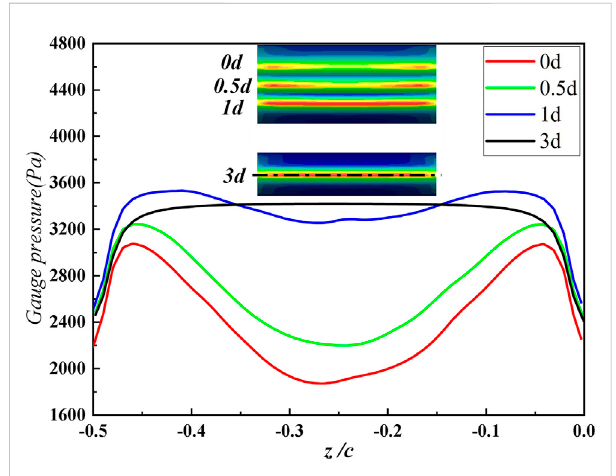
FIGURE 12 Pressure distribution on the leading edge of the airfoil.